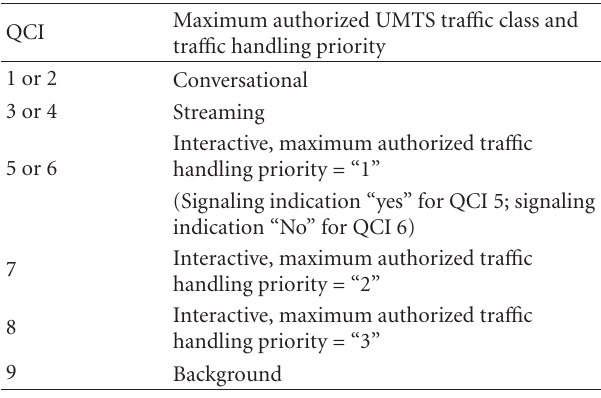
Table 6: Rules for derivation of the authorized UMTS QoS parameters from the authorized IP QoS parameters in packet gateway